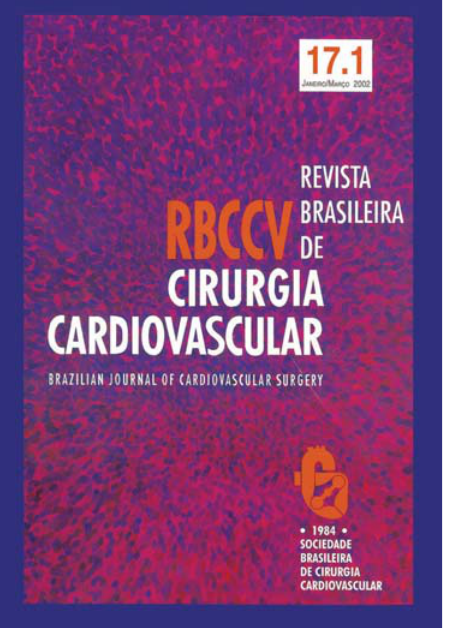
Fig. 2B – Reprodução da capa do volume